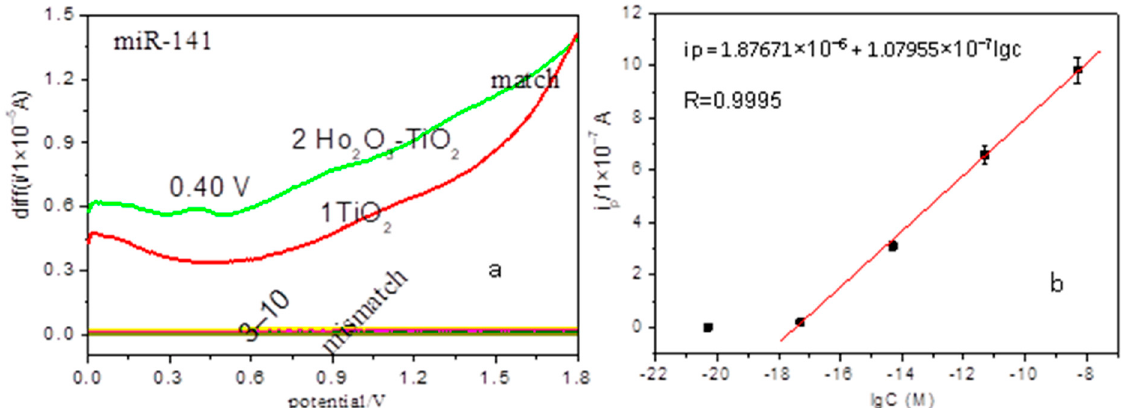
Figure 3. Electrochemical detection of cancer miRNAs. ( a ) SWV curves for miR-141: (1) match at the TiO 2 nanobelts modified electrode; match (2) and mismatch (3–10) at the Ho 2 O 3 -TiO 2 nanobelts modified electrodes; ( b ) Linear plot of anodic peak current (i pa ) versus concentration of perfect match miR-141 ranging from 0 to 5 nM at Ho 2 O 3 -TiO 2 nanobelts-modified electrodes.